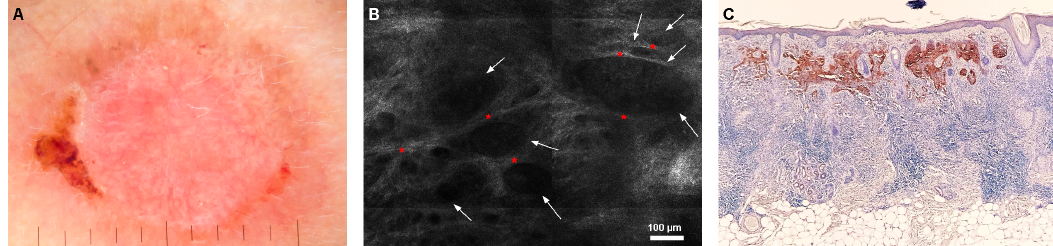
Figure 4. Infiltrative basal cell carcinoma. ( A ) Dermoscopy showing a hypopigmented lesion with structureless red shiny areas, chrysalis pattern, short fine telangiectasia, and erosion. ( B ) RCM showed multiple hyporefractile silhouettes, which appear as imprints (white arrows) outlined by bundles of bright collagen (red asterisks). ( C ) Histopathology shows tumor islands and strands that resemble the hyporefractile silhouettes observed through RCM (BerEP4 stain, magnification 4×). Keratinocyte atypia, epidermal streaming, ulceration, and inflammation were observed with comparable frequencies in all tumor subtypes. The analytic descriptive results of the confocal image analysis are summarized in Table 2. Table 2. Frequencies of confocal criteria in different histologic basal cell carcinoma subtypes. Confocal Criterion, N (%)